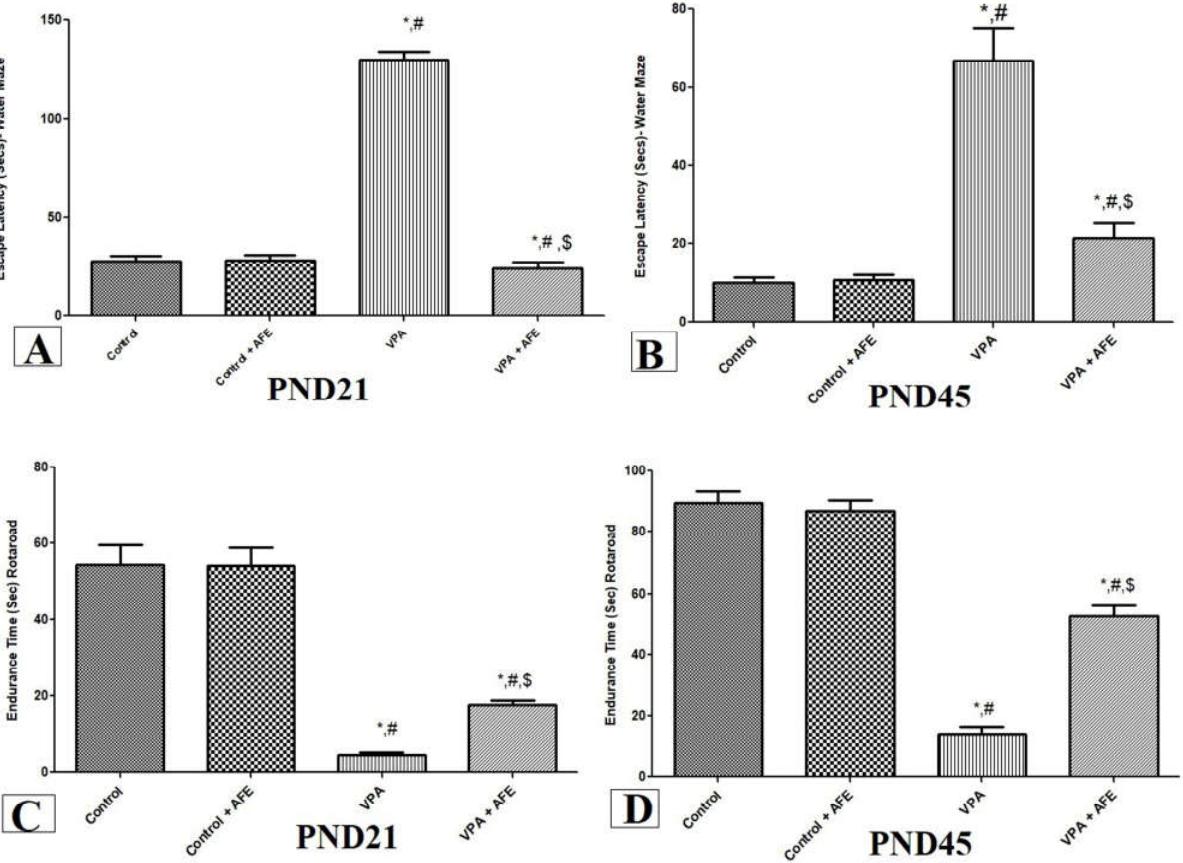
Figure 1. Effect of AFE on spatial memory and motor coordination evaluated by using the water maze and rotarod tests, respectively. The effect of AFE on the escape latency (secs) at PND21 ( A ) and PND 45 ( B ), and the effect of AFE on endurance time at PND21 ( C ) and PND45 ( D ). Data are expressed as mean ± SEM. * significant vs. control group, # significant vs. control + AFE group, $ significant vs. VPA group. p ≤ 0.05 is considered